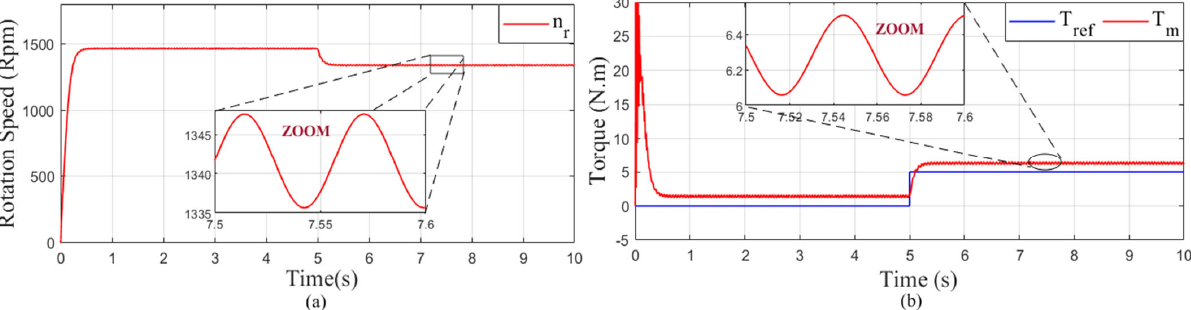
Figure 19. Performance in healthy state of IM without control: ( a ) Stator current and ( b ) THD at no ‐ load and ( c ) THD with load (5 Nm). Figure 20. Performance with IR bearing defect of IM without control: ( a ) Stator current and ( b ) THD at no ‐ load and ( c ) THD with load (5 Nm). Figure 21. Performance with OR bearing defect of IM without control: ( a ) Stator current and ( b ) THD at no ‐ load and ( c ) THD with load (5 Nm).